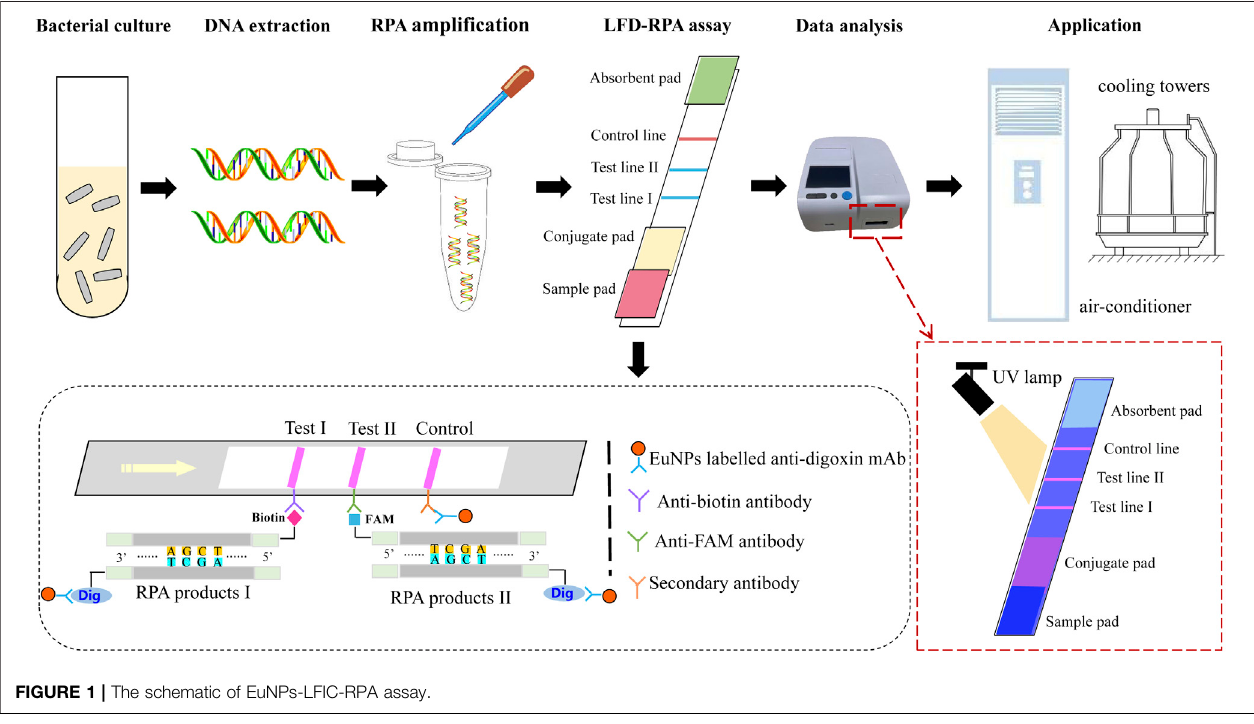
FIGURE 1 | The schematic of EuNPs-LFIC-RPA assay.